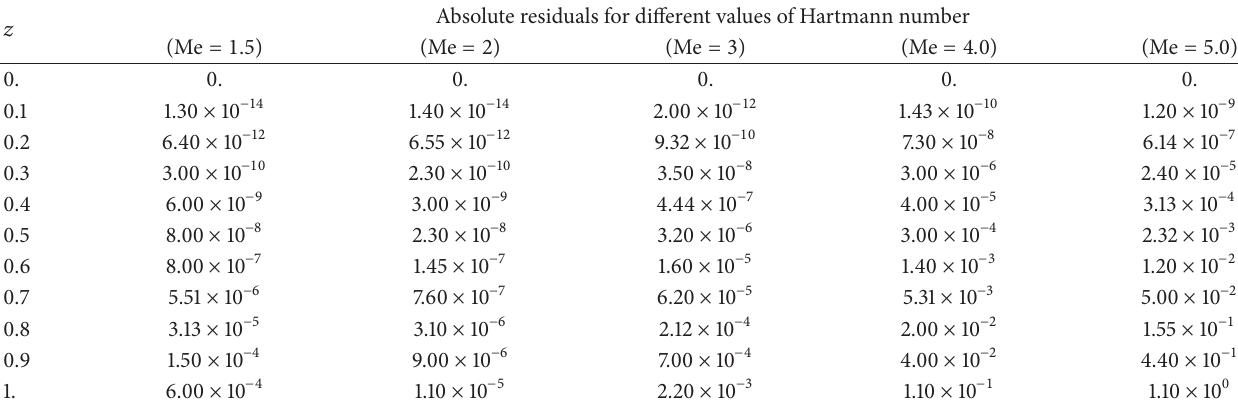
Table 3: Absolute residuals for different values of Me keeping Re and 𝛾